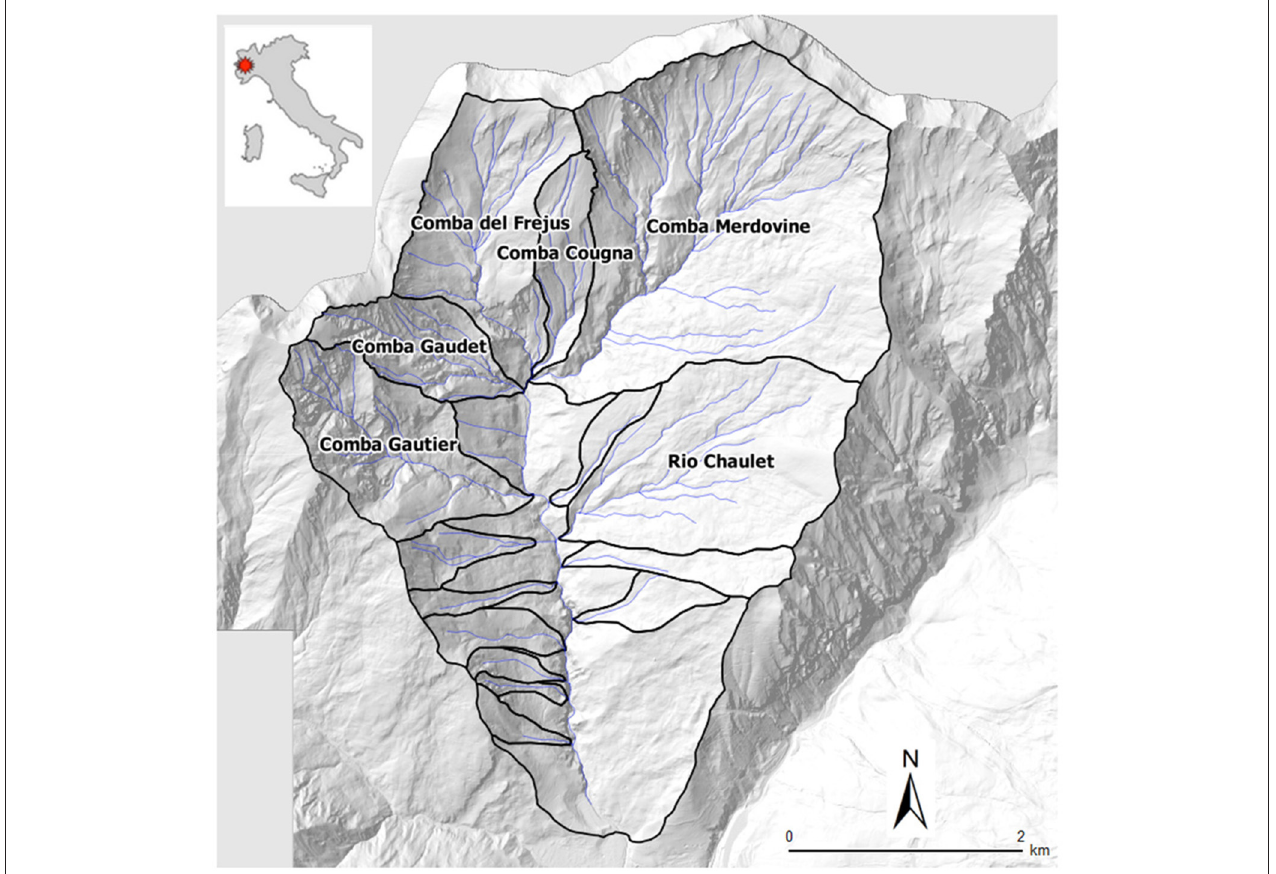
FIGURE 1 | Rio Frejus catchment and its